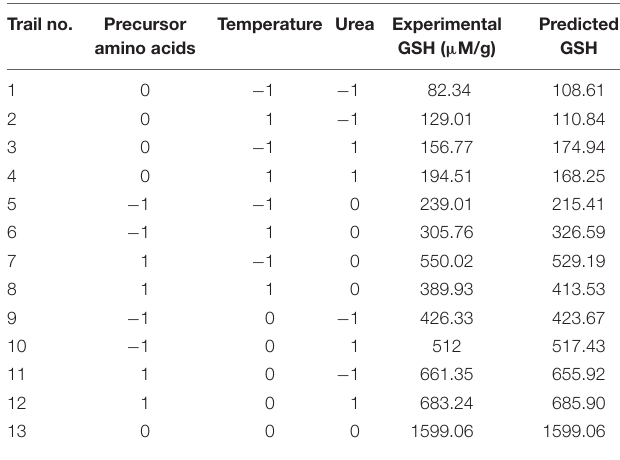
TABLE 4 | Box–Behnken design of GSH production by L. plantarum as influenced by amino acids, temperature, and urea. Trail